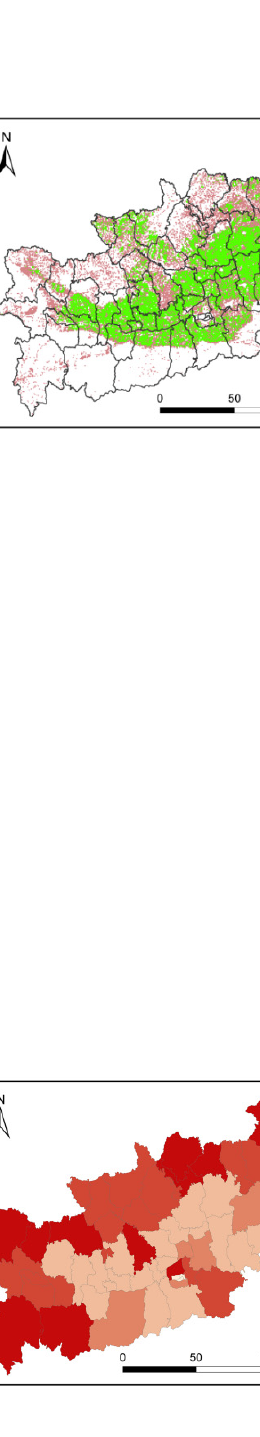
Figure 4. NGPR of 54 counties and districts in Guanzhong: ( A ) 2000, ( B ) 2010, and ( C ) 2019.